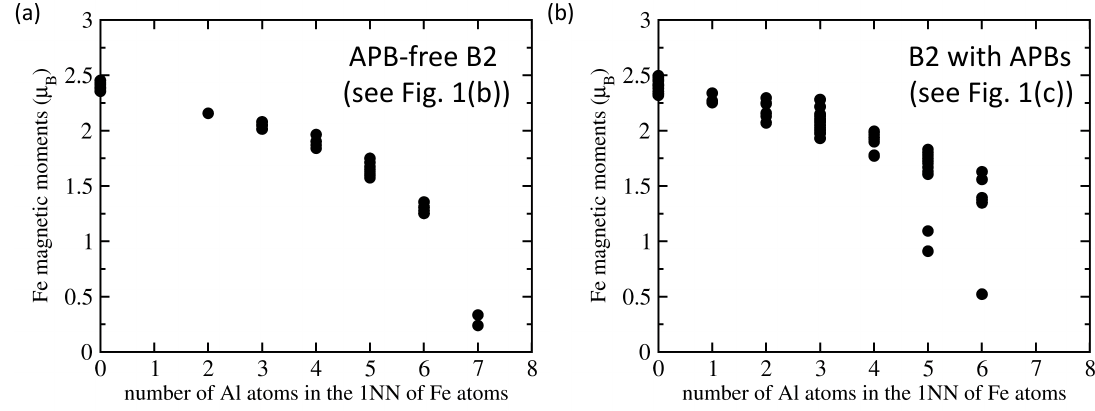
Figure 2. Computed local magnetic moments of Fe atoms as a function of the number of Al atoms in the first nearest neighbor (1NN) shell of Fe atoms. Part ( a ) shows them in the APB-free B2 phase (visualized in Figure 1b) and part ( b ) contains the values for the B2 phase with APBs shown in Figure